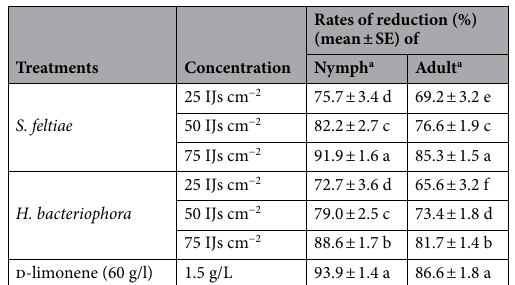
Table 6. Henderson-Tilton adjusted rates of population reduction of Dactylopius opuntiae at 12 days after treatments under field conditions. a In each column, averaged means followed by the same letters are not significantly different according to Tukey’s LSD test at α = 0.05.